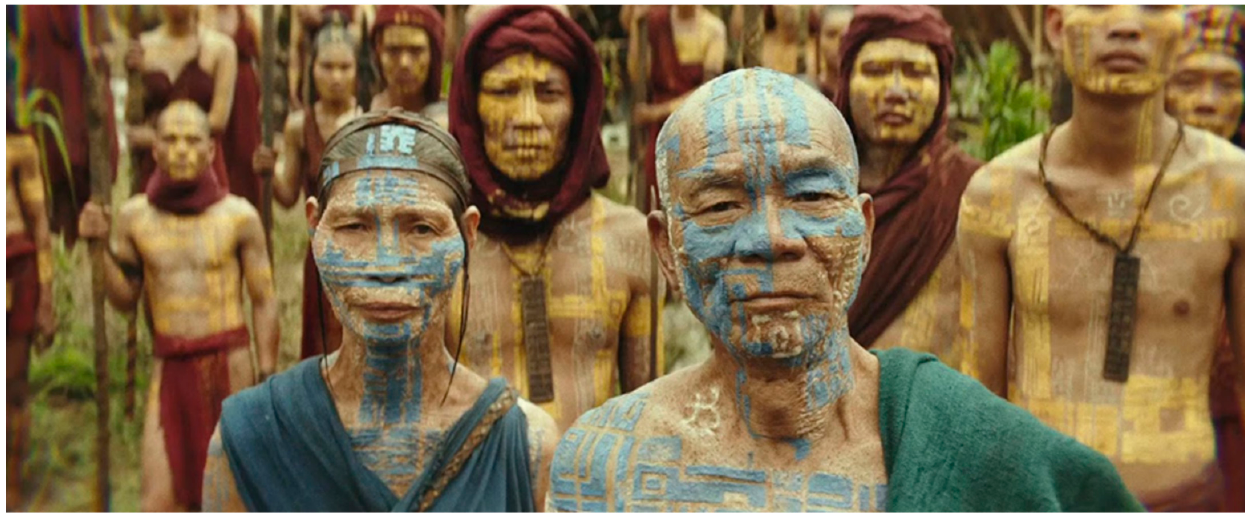
Figure 18. The leaders of the tribe are a man and a woman. The members wear paintings on their faces and bodies almost as if they were Buddhist “monks” (2017). http://phubb.blogspot.com/2017/08/kong-skull-island-2017_3.html (accessed on 1 January 2021).